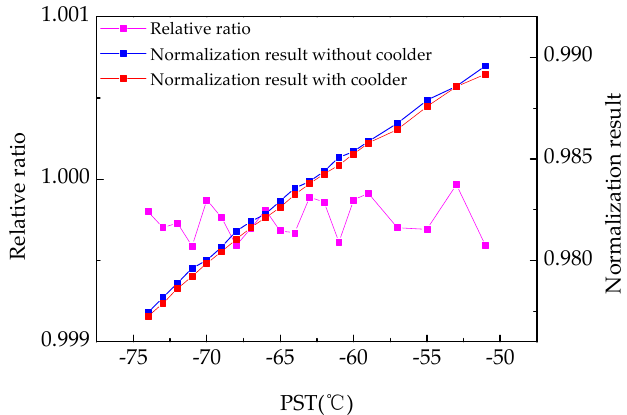
Figure 16. G(T) consistency comparison across different heat sink temperatures. The difference between the two sets of results was less than 0.05% after performing temperature correction on the filter